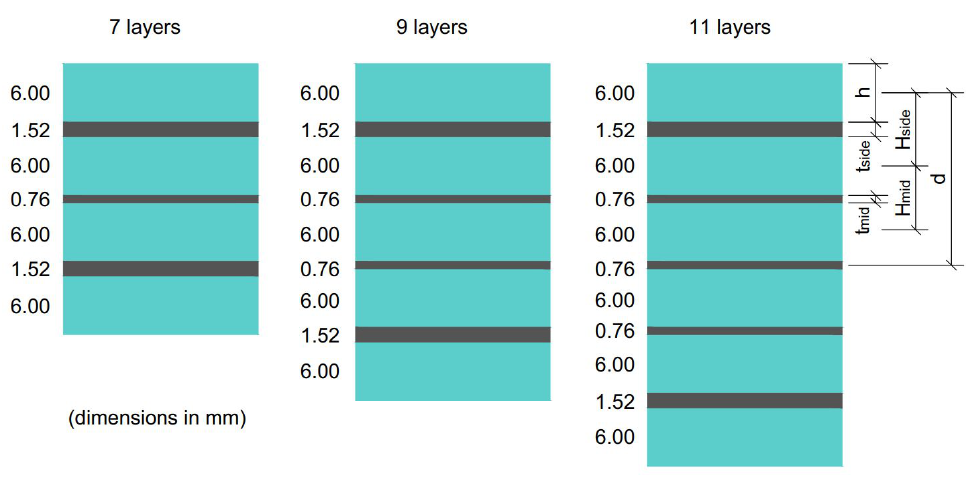
Figure 1. Glass and polymer interlayer configurations. Nominal thicknesses.